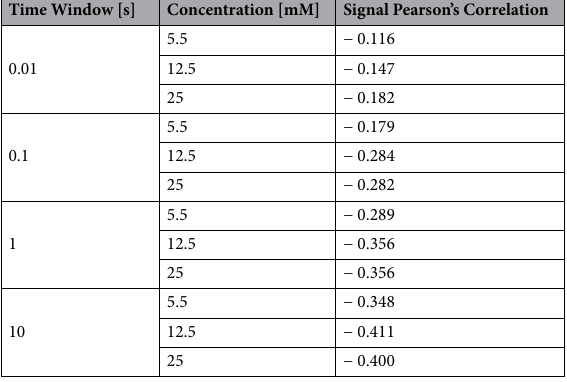
Table 1. Average signal correlation values for various time